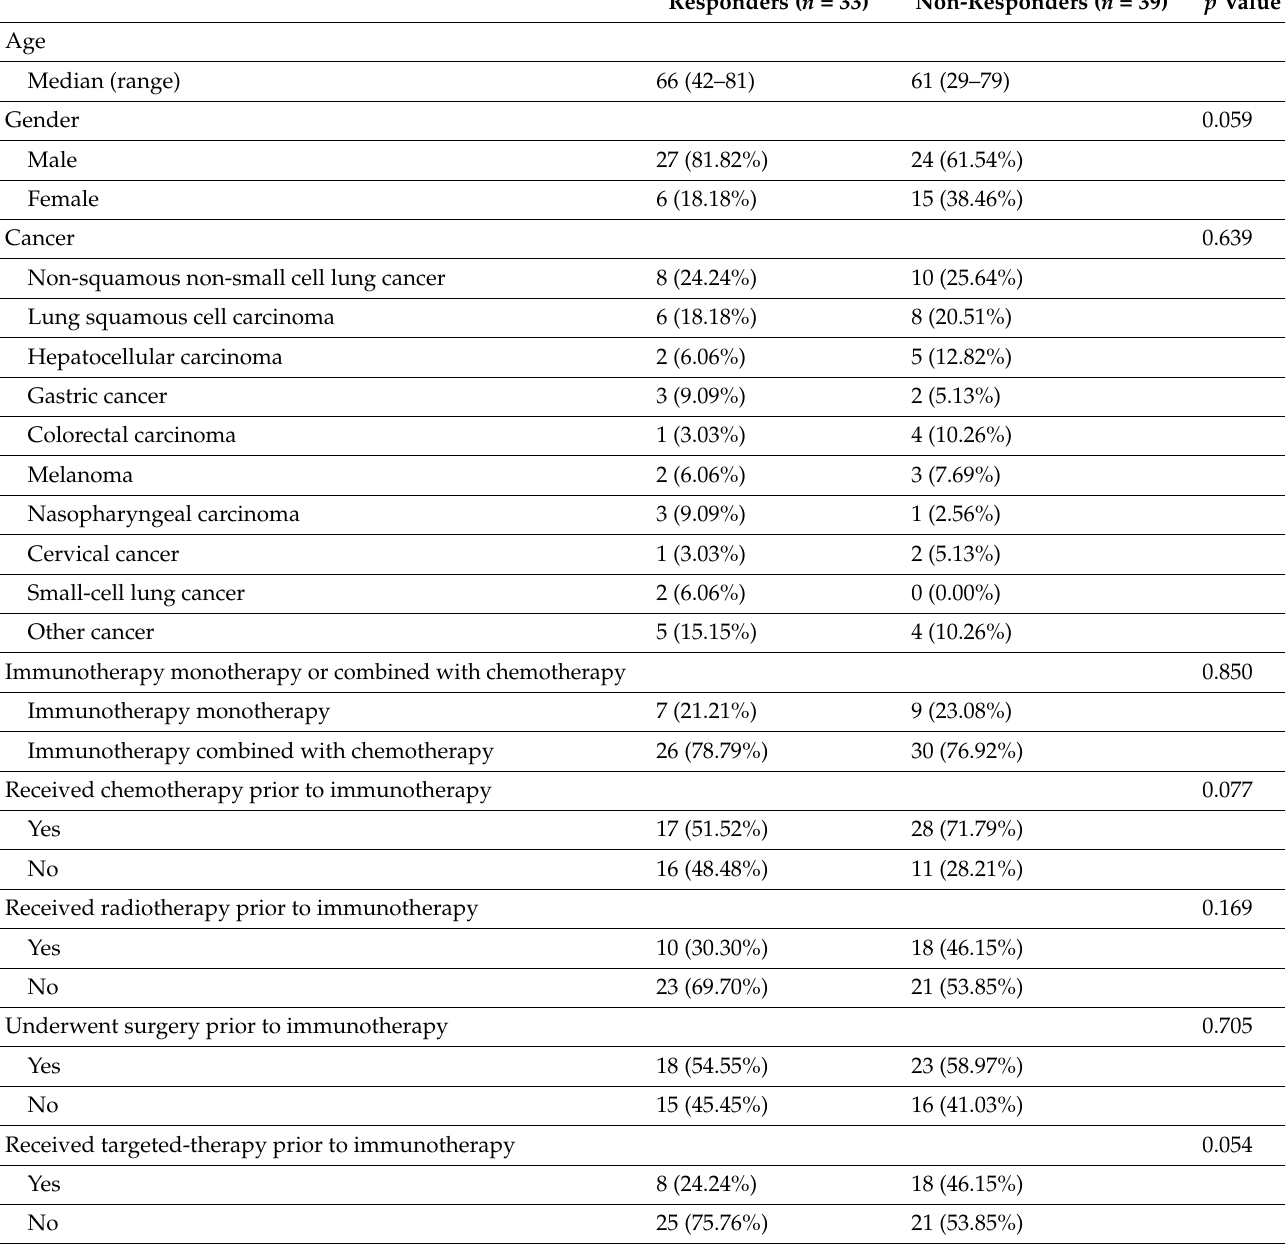
Table 2. The characteristics of responders and non-responders at baseline ( n =